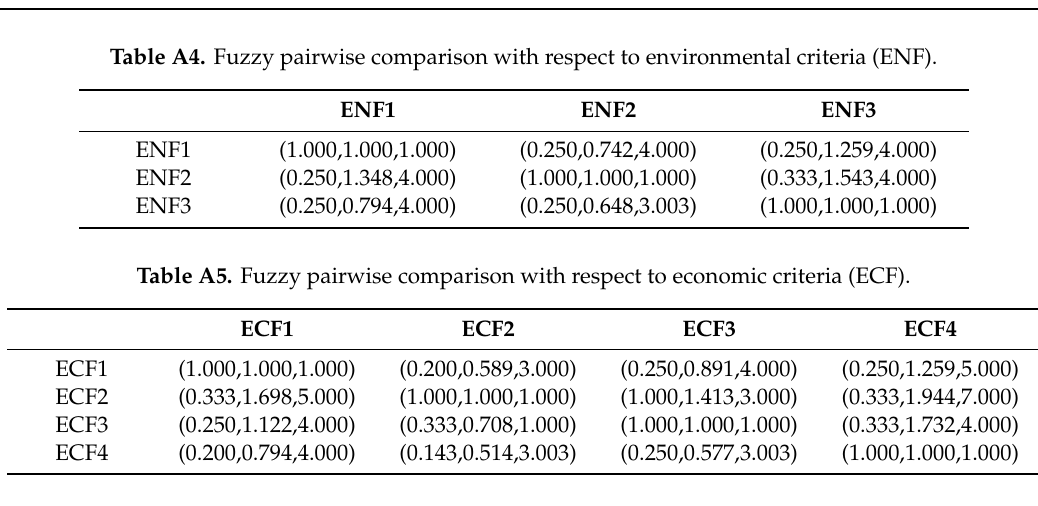
Table A6. Fuzzy pairwise comparison with respect to technical criteria